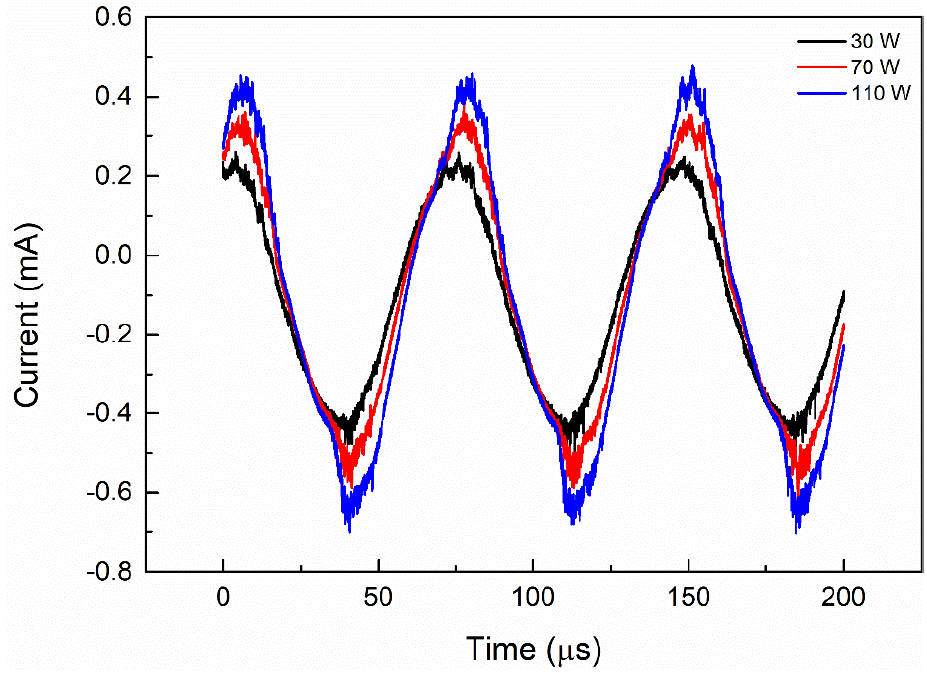
Figure 7. Effect of discharge power on the current signals for empty tube. Figure 7. E ff ect of discharge power on the current signals for empty